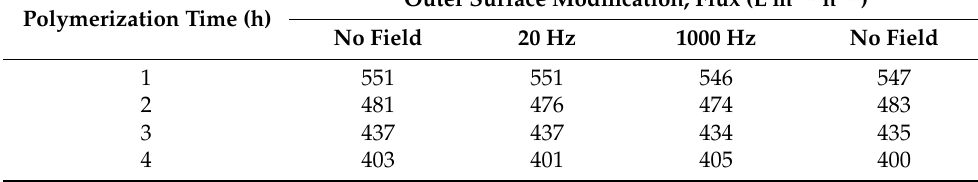
Table 2. Variation of water flux for outer surface modification. Results are shown in the absence and presence of a 20 and 1000 Hz oscillating magnetic field. Average results are provided with a range of ± 8 L m − 2 h − 1 . The feed pressure was 10.3 kPa.